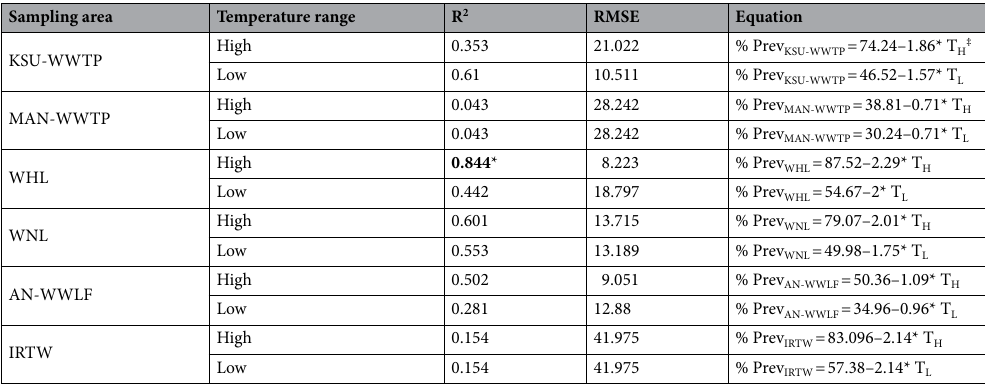
Table 4. The significance of impact of high or low-temperature ranges on HRVA prevalence in various sampling areas. % Prev refers to HAdV prevalence percentage at different sampling areas. RMSE denotes the root mean squared error which is an absolute measure of fit. *Significant at p < 0.05. ‡ T H represents the highest temperature detected whereas T L denoted lowest temperature